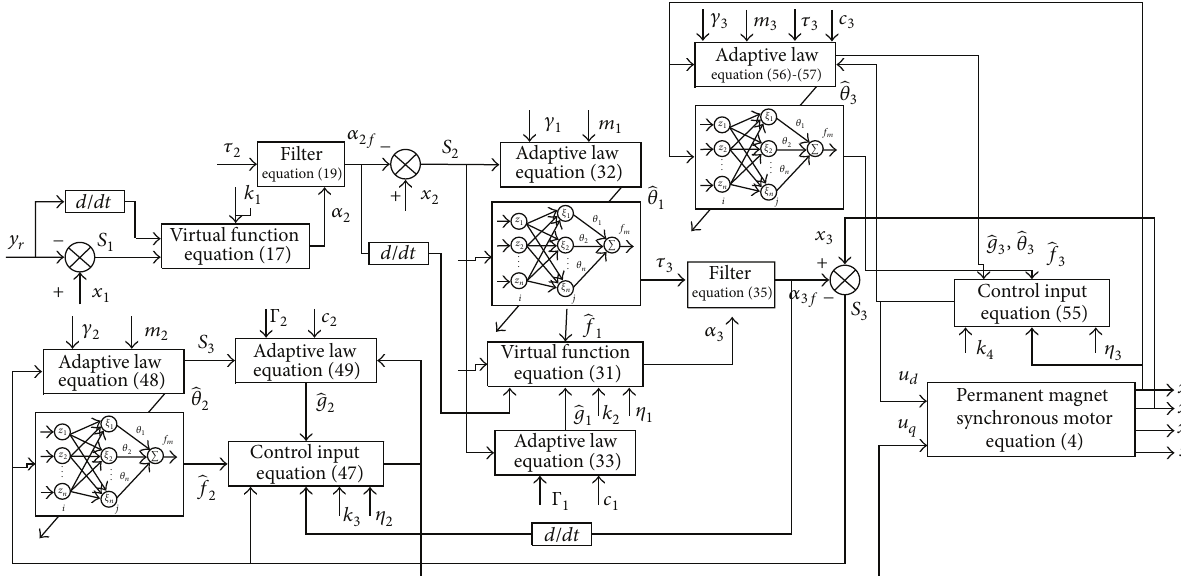
Figure 5: Block diagram of the adaptive DSC system based on RBFNN for PMSM.